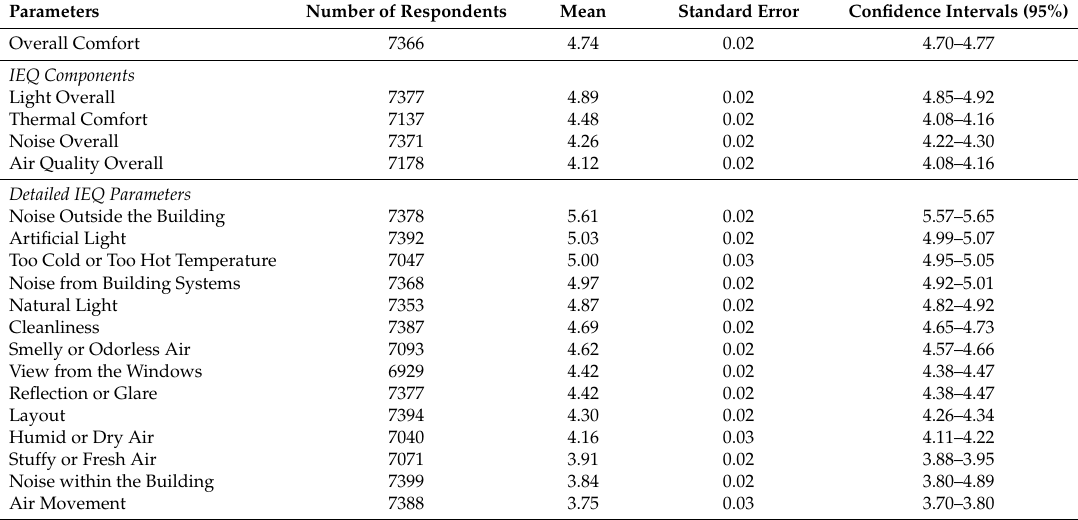
Table 3. Description of overall comfort and satisfaction with indoor environmental quality (IEQ) and detailed indoor environmental parameters in OFFICAIR study (item-scale: from 1-Dissatisfied to